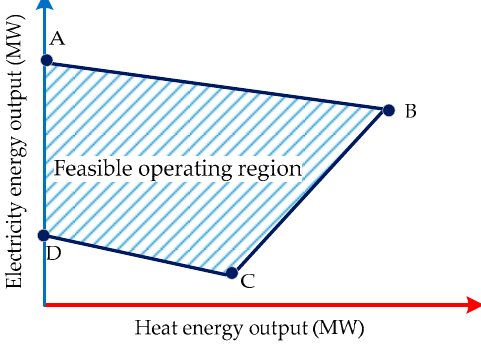
Figure 2. Feasible operating region of a combined heat and power (CHP) unit.